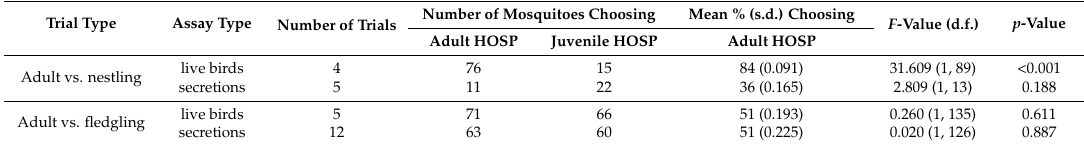
Table 1. Comparison of adult house sparrows versus nestlings or fledglings in both live-bird and secretion-only